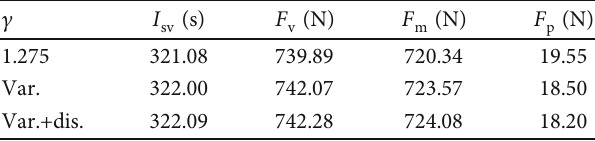
Table 2: Performance of the nozzle with various contours.